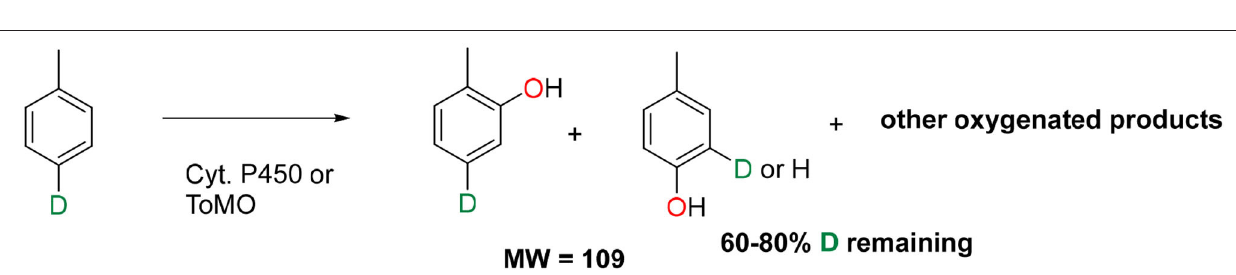
FIGURE 1 | Ring or chain activation of toluene by (A) ROS accumulated by Fenton’s reactions or (B) high valent metal oxygenate species in metalloproteins. The mechanism (B) can also be proceeded by the Bray–Gorin mechanism. Reproduced from Ramu et al. (2017). Copyright 2017 Elsevier B.V.